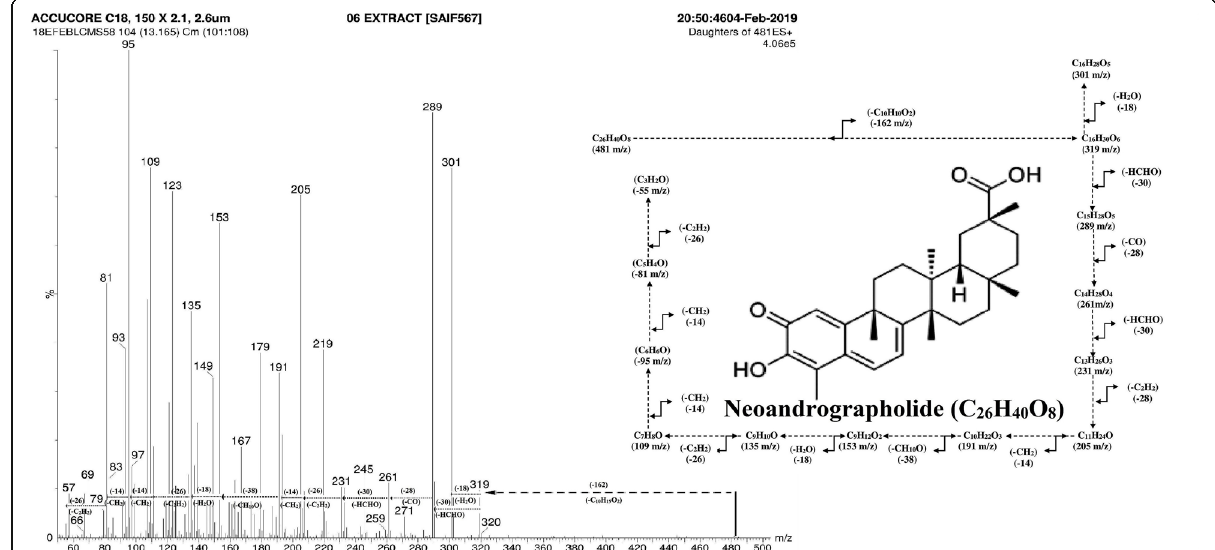
Fig. 9 Fragmentation pathway of Neoandrographolide